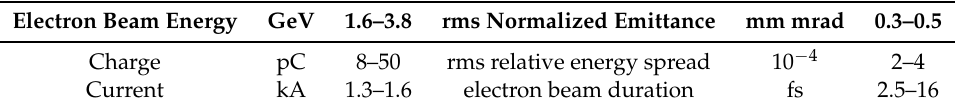
Table 1. Electron beam for MariX Free Electron Laser (FEL).